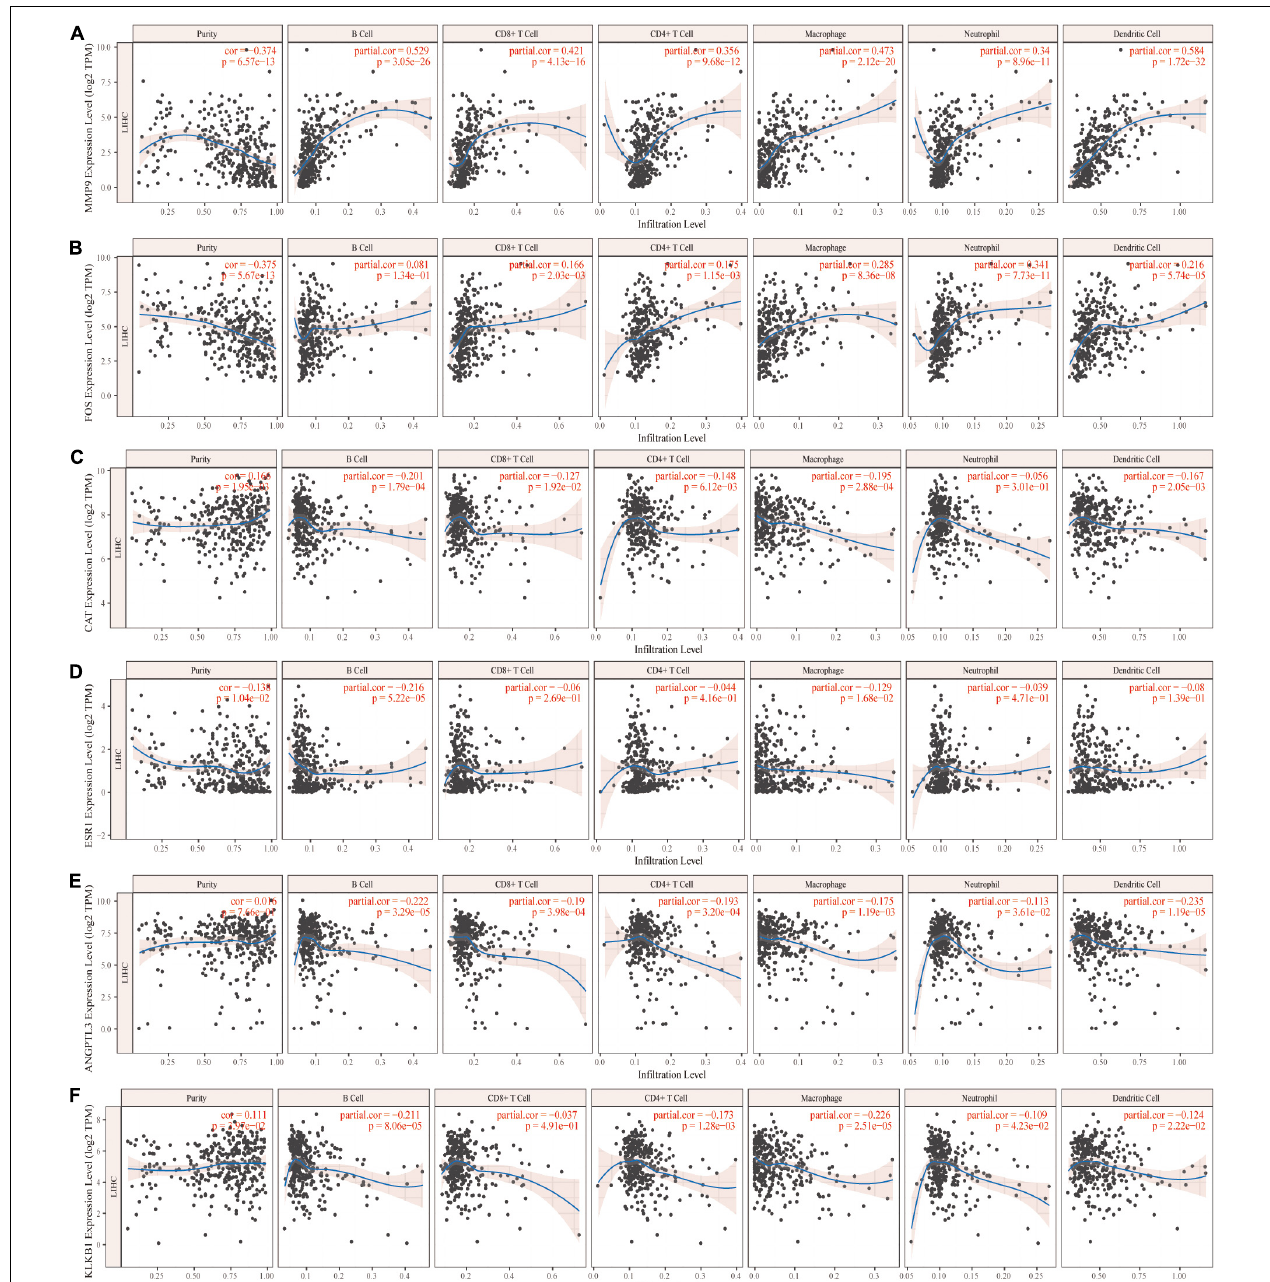
FIGURE 4 | Correlation of the characteristic immune-related genes (IRGs) and the immune microenvironment in hepatocellular carcinoma (HCC) patients (A–F) .